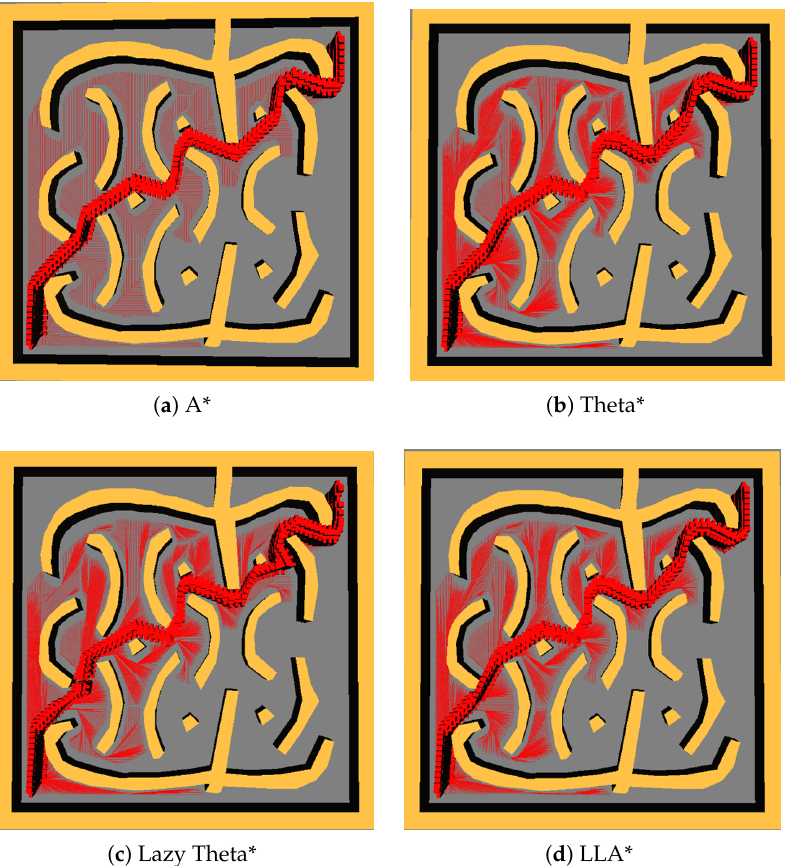
Figure 9. The planning results for an animated character using A* ( a ), Theta* ( b ), Lazy Theta* ( c ), and LLA* ( d ) on Maze #1. The extension details and final composite moving trajectories are shown in red